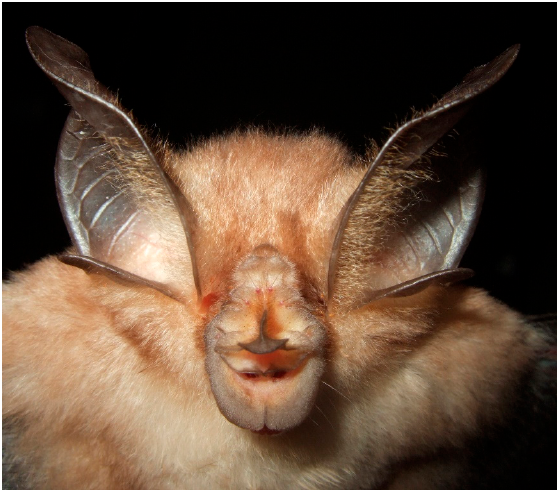
Figure 7. Rhinolophus marshalli , adult male. Photograph by Vu Dinh Thong.